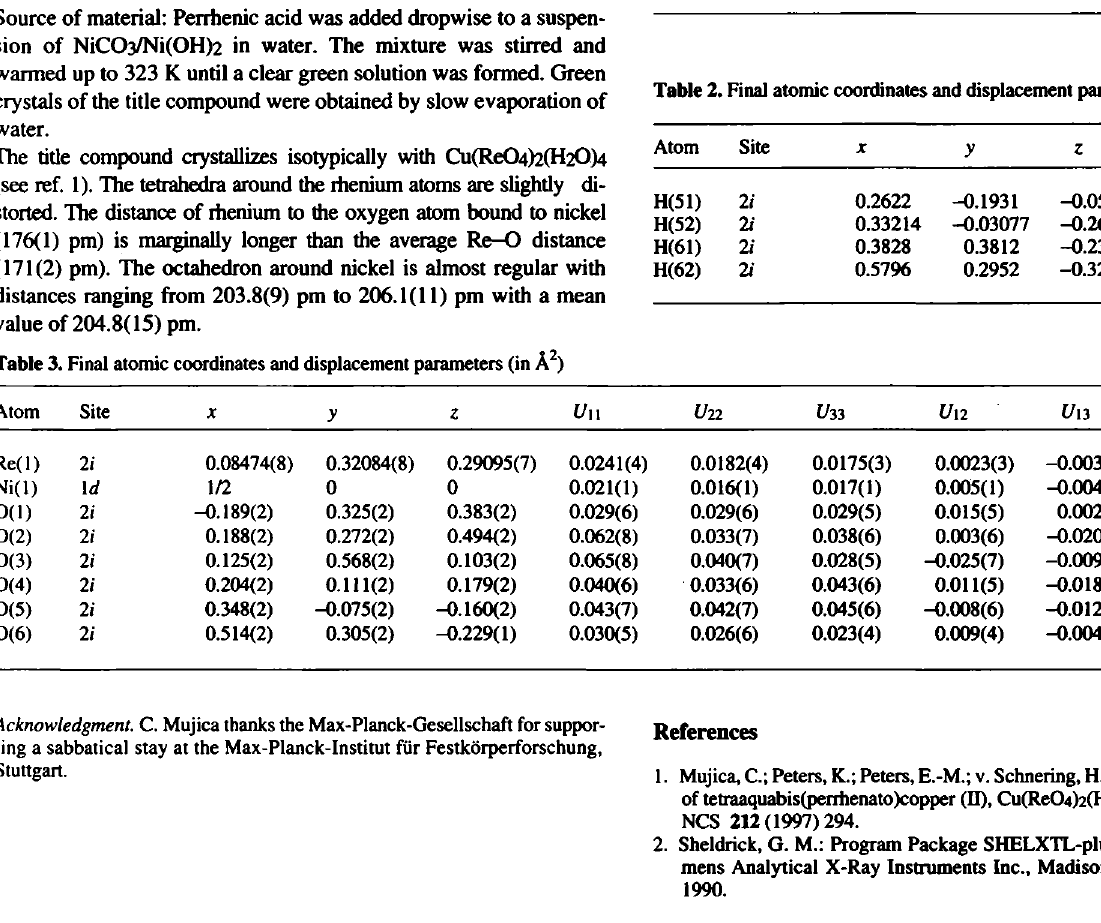
Table 2. Final atomic coordinates and displacement parameters (in Â 2